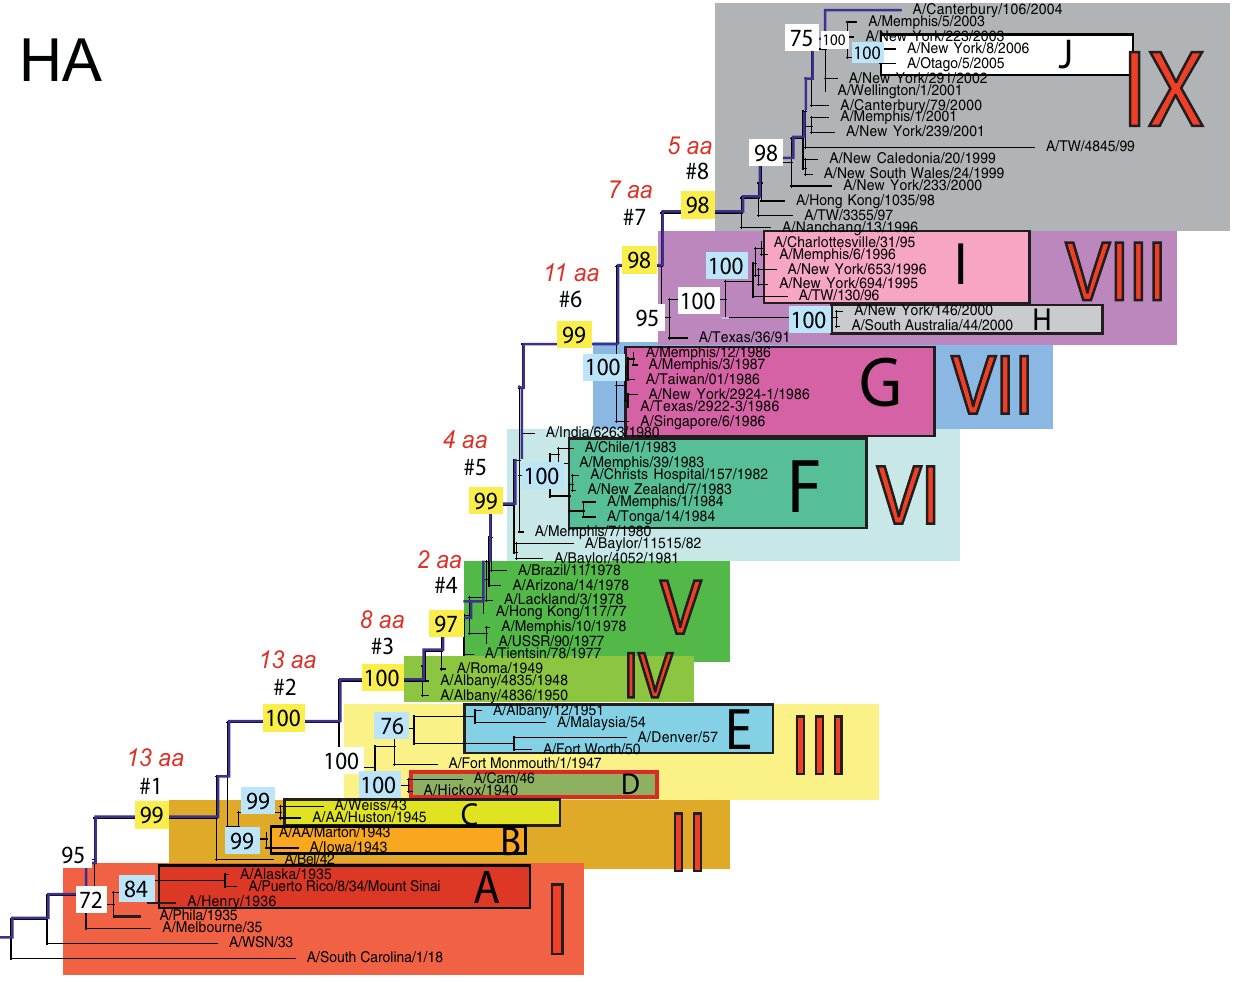
Figure 4. Phylogenetic relationships of the HA gene of A/H1N1 influenza viruses (n=71) sampled globally from 1918–2006, estimated using ML. Rooting, scale, and color scheme are the same as those used in Figure 1.